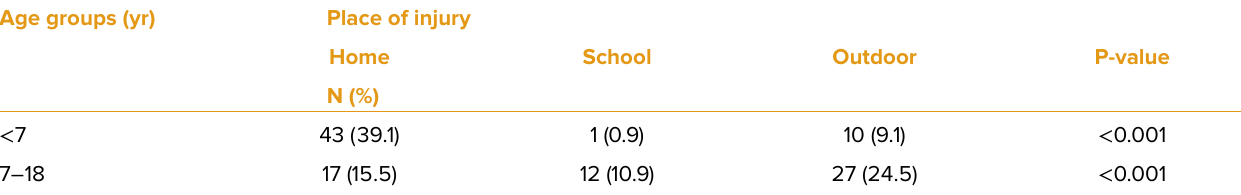
Table 4. Place of injury according to age groups. Age groups (yr) Place of